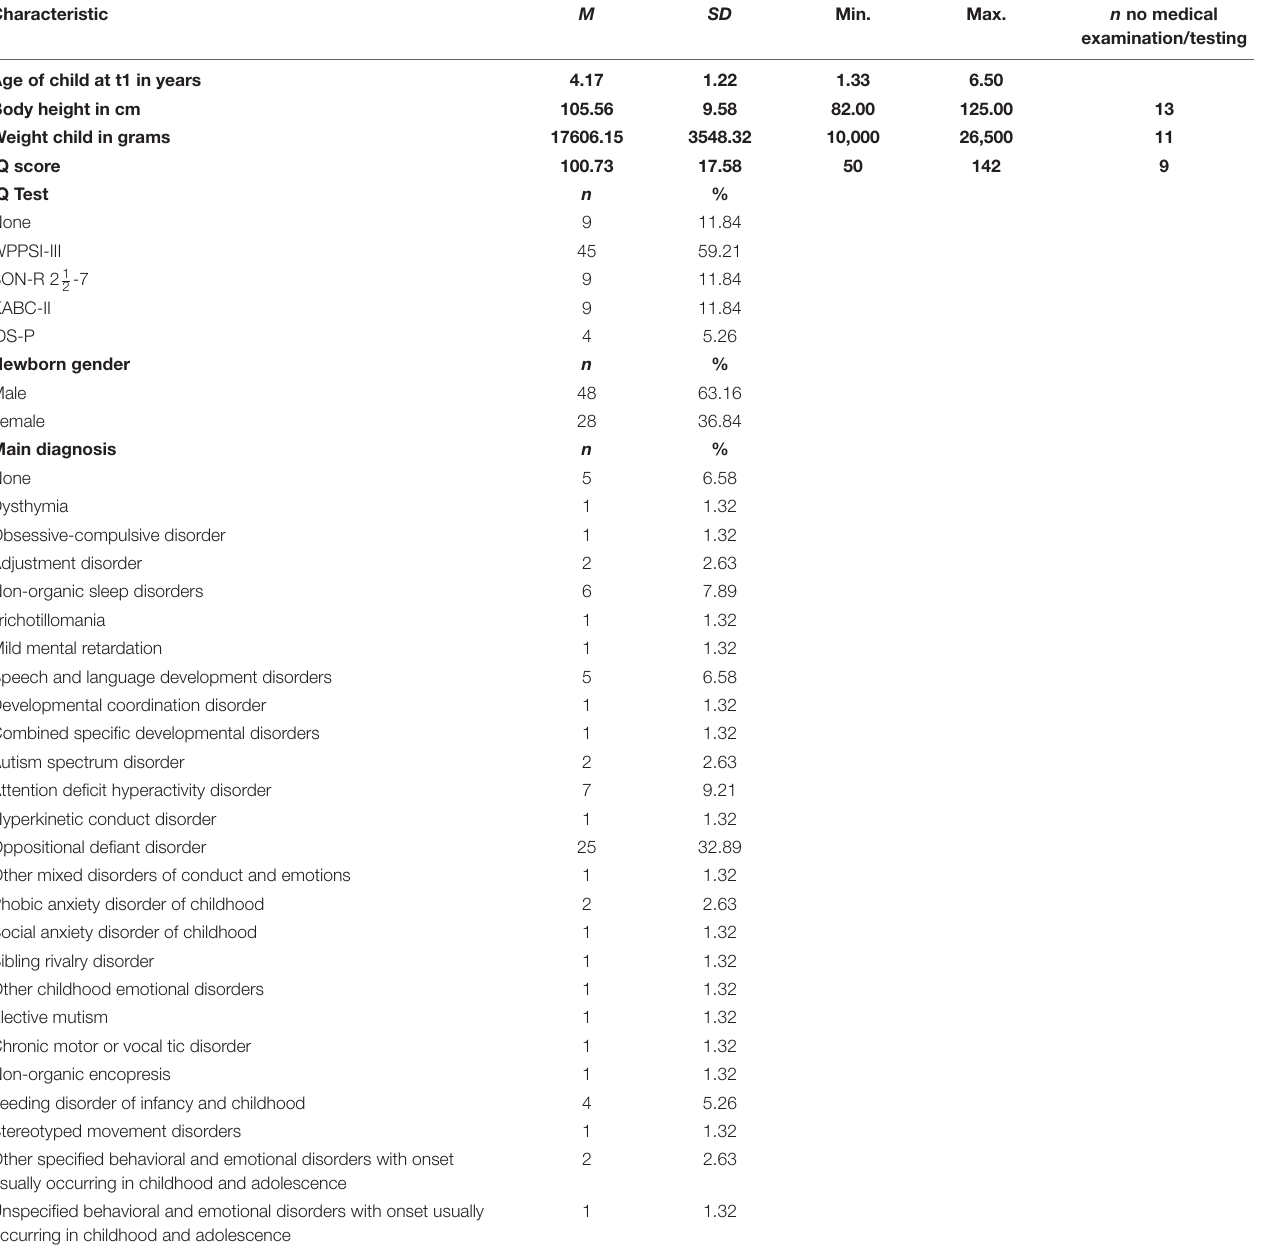
TABLE 1 | Characteristics of sample at t1 ( n =